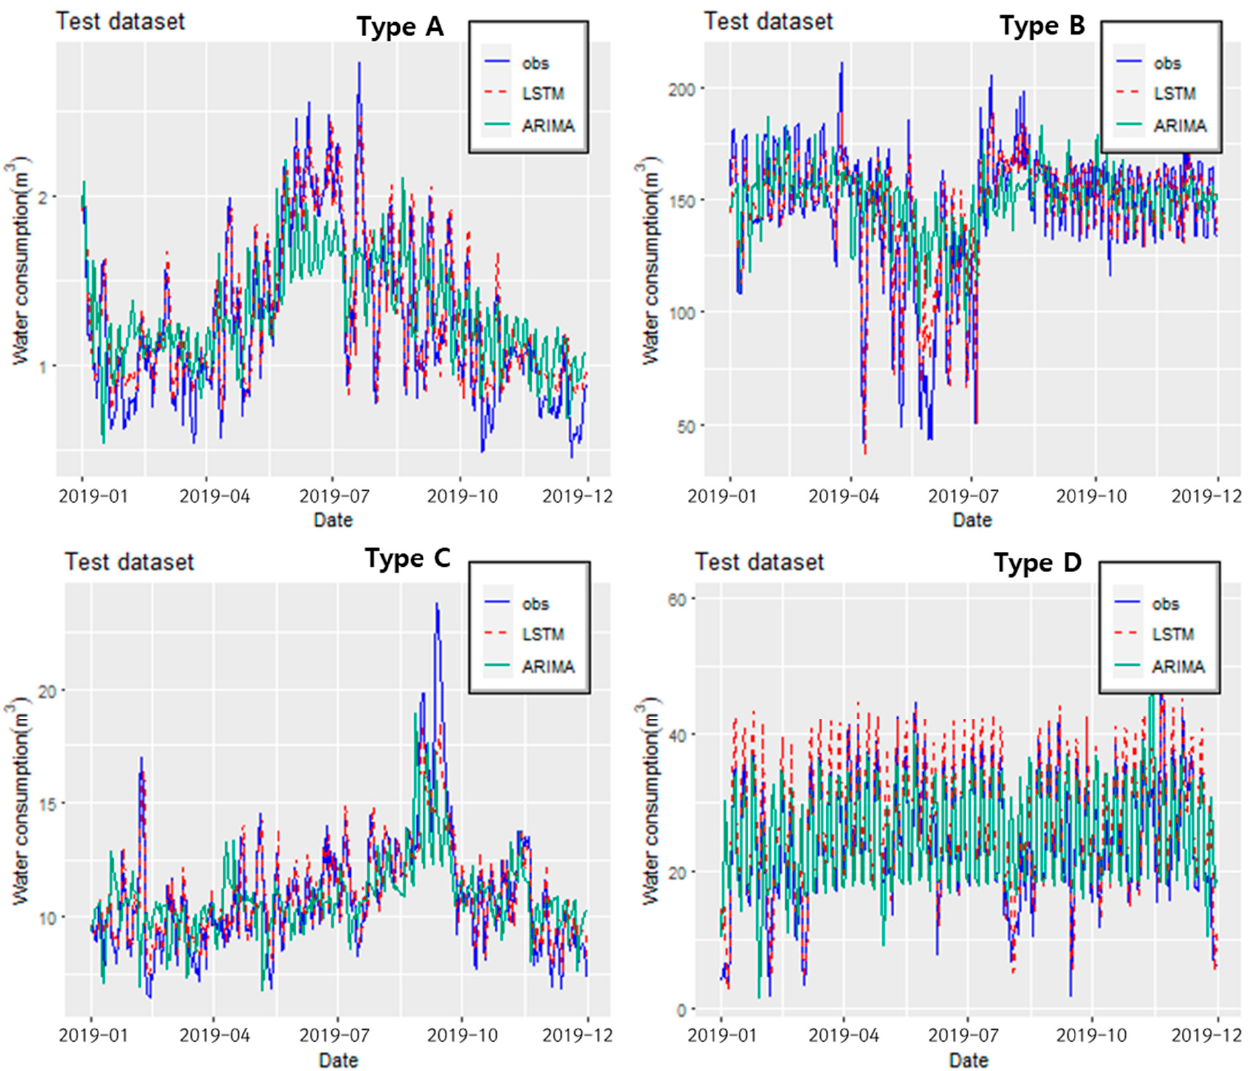
Figure 10. Time series of the predicted and observed values in the test dataset for each model. Taylor diagrams are mathematical diagrams designed to graphically indicate the RMSE, CC and Standard deviation (SD) [53]. Figure 11 shows a Taylor diagram for each region. Green dotted line indicates RMSE, blue dotted line indicates SD, black dotted line indicates CC, and the green square point is SD of observation. In general, the smaller the RMSE and SD, and the closer CC is to one, the better the model performance. Here, the points that are closer to the green square point in this diagram mean better model perfor- mance, and the red and blue points represent the performance of ARIMA and LSTM in the diagram. As a result, blue points are closer to the green square point than red points. Therefore, the LSTM model outperforms the ARIMA model in predicting water consump- tion at the household level as it can be trained with various patterns.